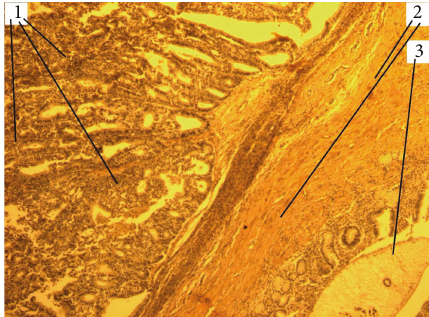
Figure 7: Experimental cholangiocarcinoma with a tender stroma in the setting of SO. HE staining, magni fi cation 200x (1: adenocarcinoma; 2: coarse cholangiectasis wall; 3: opisthorchii in cholangiectasis).